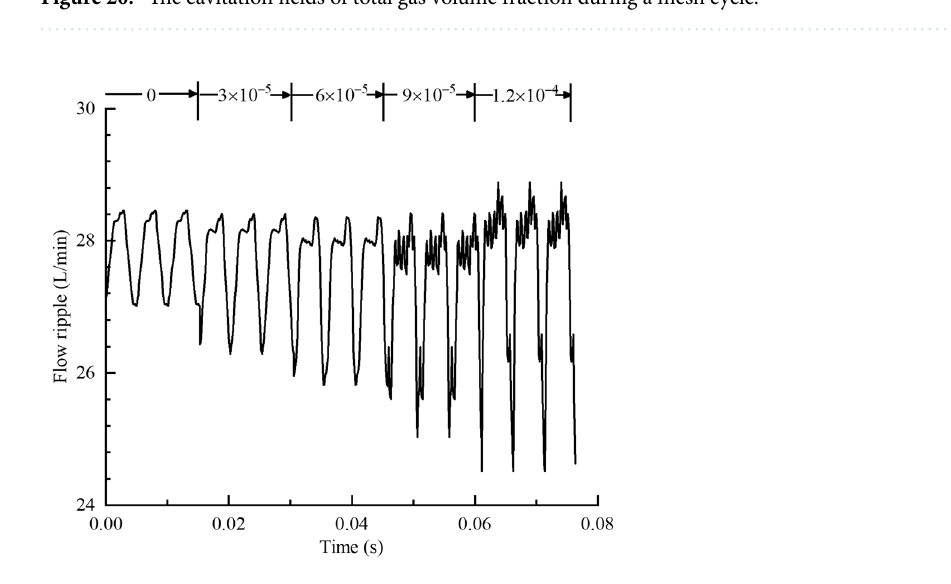
Figure 21. Flow ripple results under different gas volume